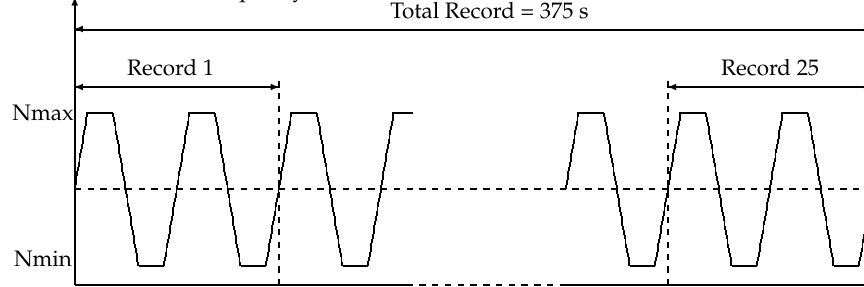
Figure 14. Signatures, 1 period, N ref = 50.